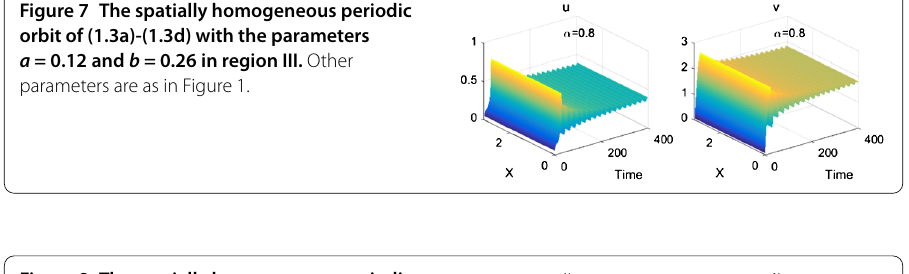
Figure 8 The spatially homogeneous periodic orbit of (1.3a)-(1.3d) with the first-order derivative and the parameters a = 0.12 and b = 0.26 in region III. Other parameters are as in Figure 1.